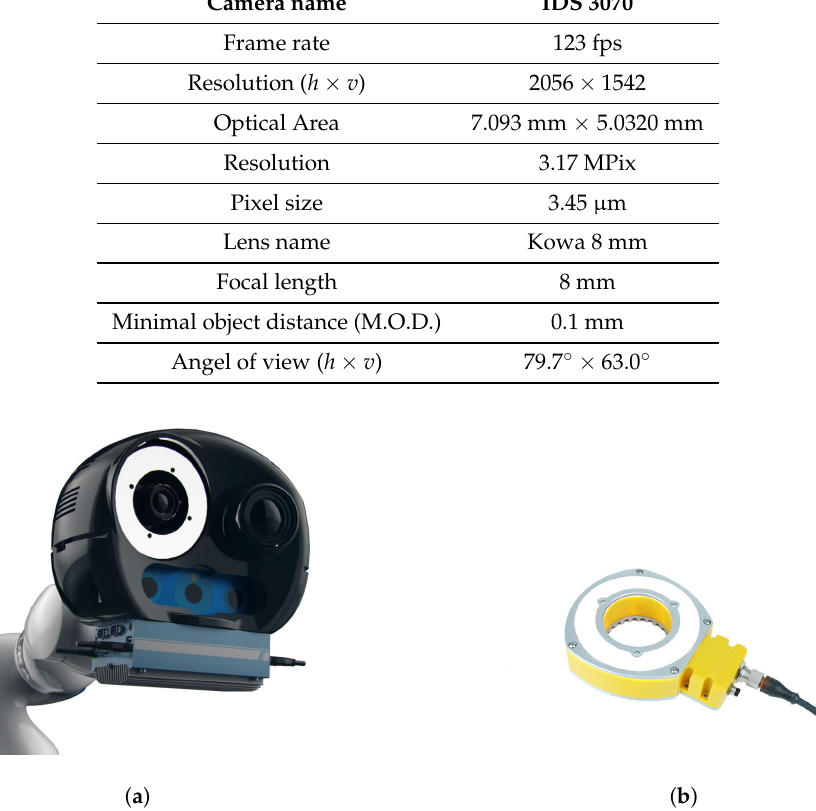
Figure 2. ( a ) Vision-based sensory system mounted on the robot; ( b ) additional lighting around the inspection